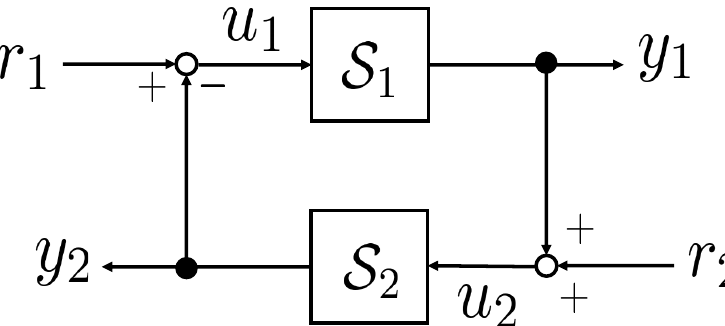
Figure 2. Negative feedback interconnection of subsystems S i , i ∈ { 1,2 }